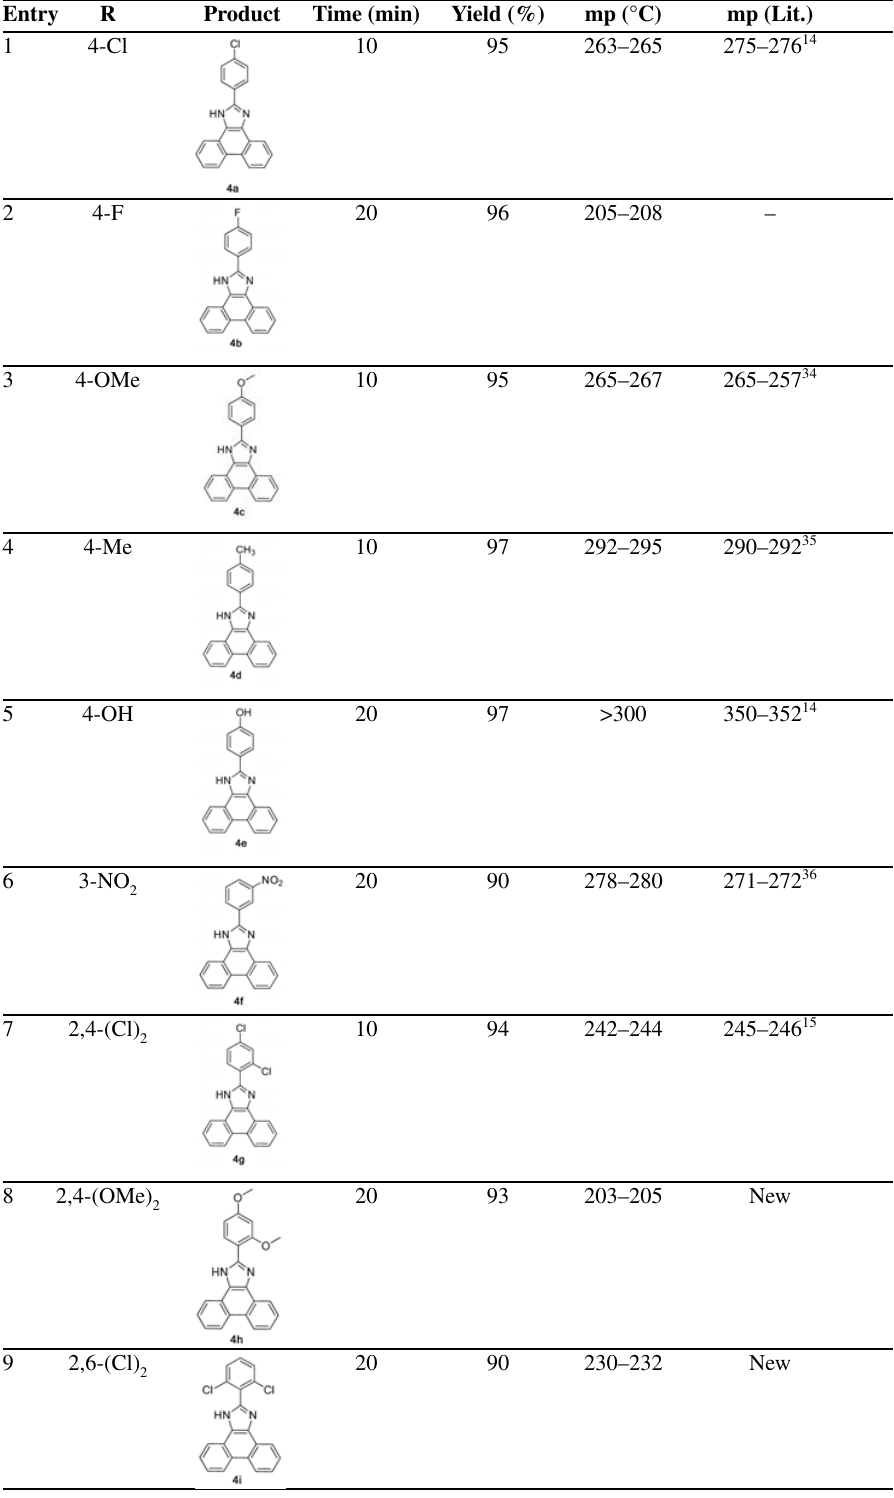
Table 2: Synthesis of 2,4,5-trisubstituted phenanthroimidazoles ( 4 ) in the presence of SBA-Pr-SO reflux conditions in acetic acid.